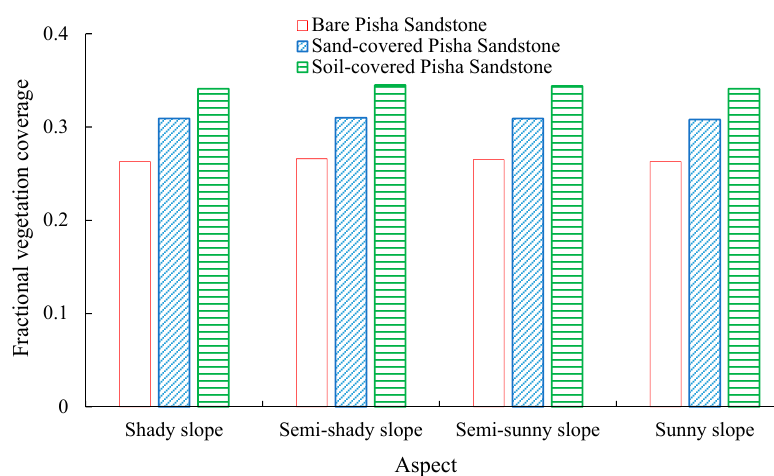
Figure 14. Variations of fractional vegetation coverage and aspect in different Pisha Sandstone types.